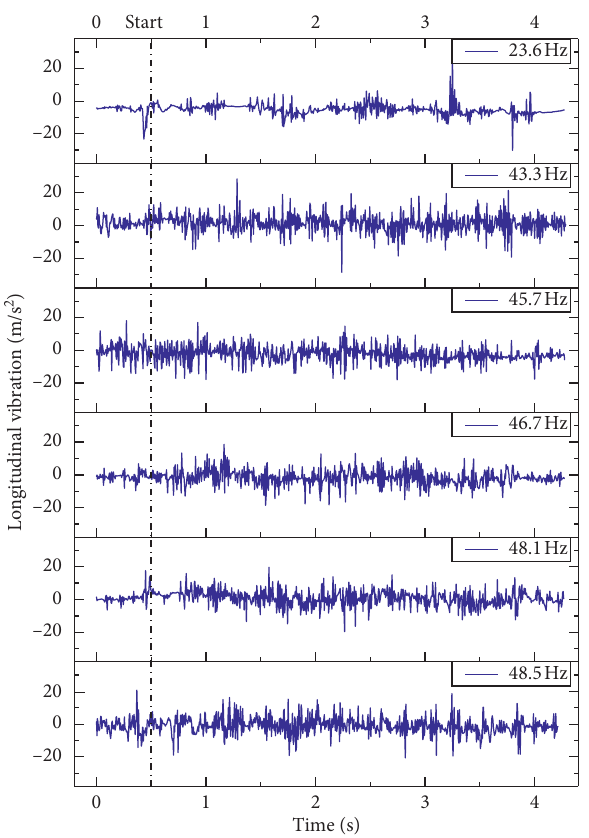
Figure 14: Longitudinal rope vibration under different excitation frequencies.